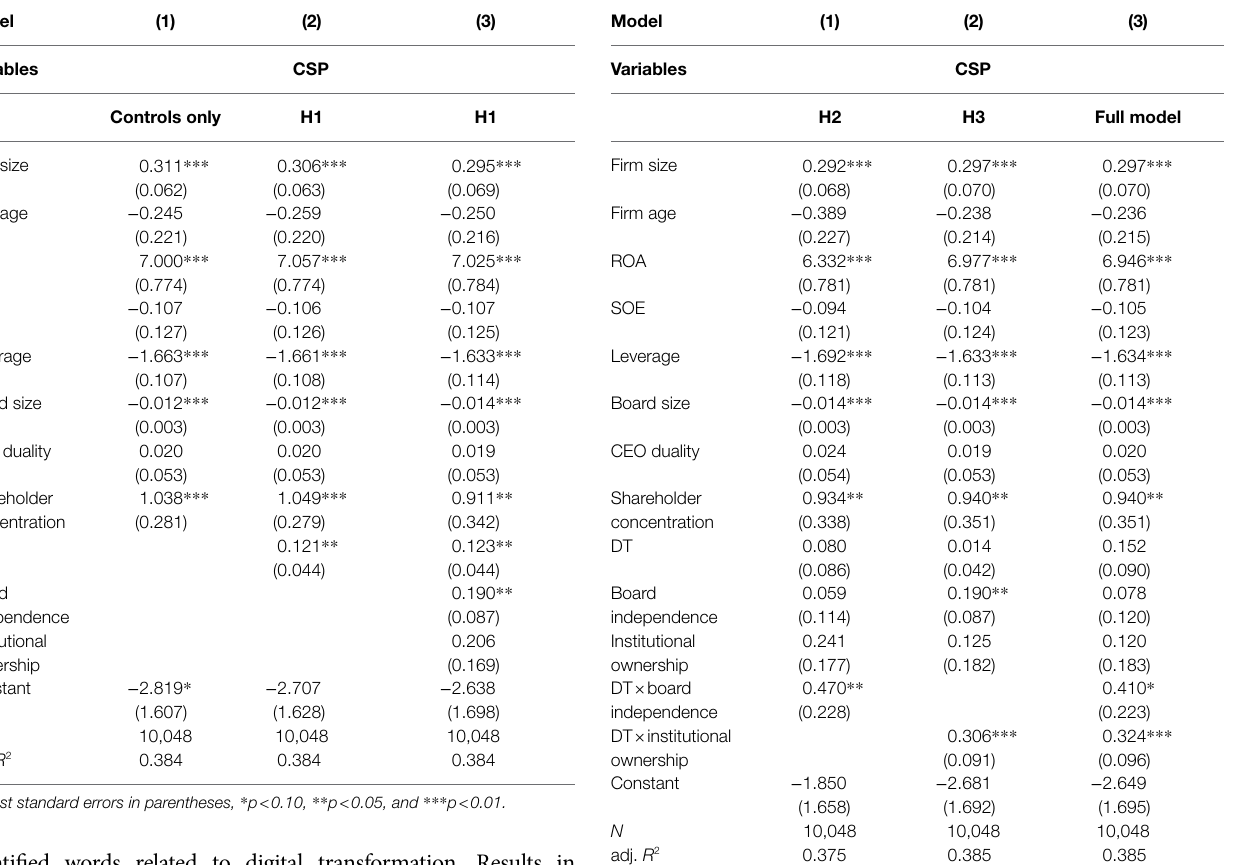
TABLE 4 | Baseline regressions: digital transformation and CSP. TABLE 5 | Moderating effect